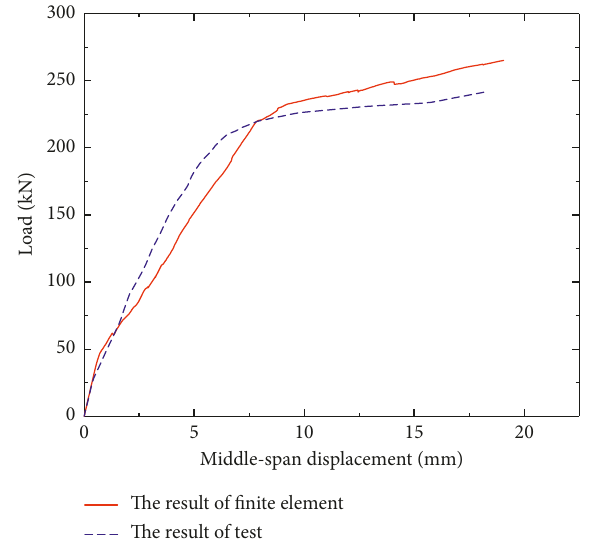
Figure 10: Comparison of load and displacement curves between test model and finite element